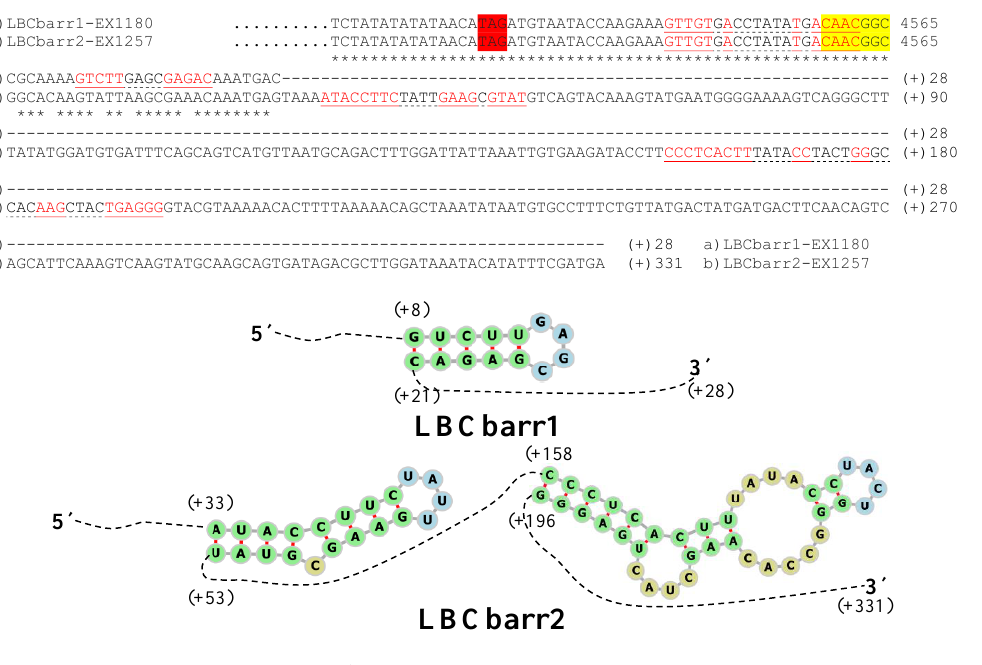
Figure 4. cDNA of 3 ′ -extra sequences and proximal canonical sequences of TdV-LBCbarr1-EX1180 and TdV-LBCbarr2-EX1257 genomes. The CAACGGC-3 ′ ends of canonical sequences are highlighted. The protein synthesis stop codons of Gag-Pol are red-shaded. Nucleotides of palindromic sequences are shown in red. Stem-loops are underlined. The unpaired nucleotides of each loop are dot underlined. Asterisks (*) indicate identical nucleotides. The secondary RNA structures of possible 3 ′ stem-loops are shown at the bottom of the sequences.